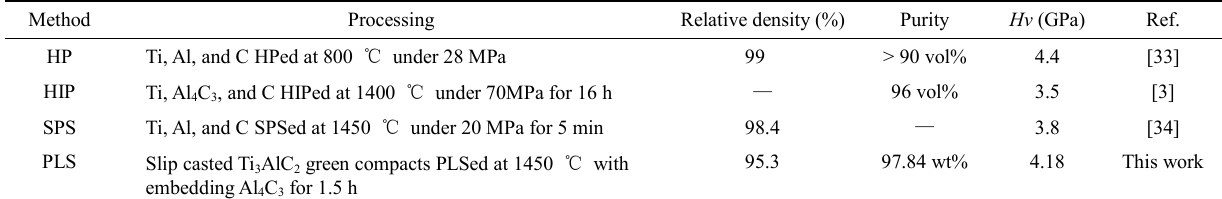
Fig. 11 Dependence of the thermal conductivity on the Fig. 12 Dependence of the electrical resistivity on the sintering temperature of Ti 3 AlC 2 sample sintered with or sintering temperature of Ti 3 AlC 2 sample sintered with or without Al 4 C 3 embedding powders. without Al 4 C 3 embedding powders. Table 3 Comparison of the properties of Ti 3 AlC 2 samples prepared by HP, HIP, SPS, and